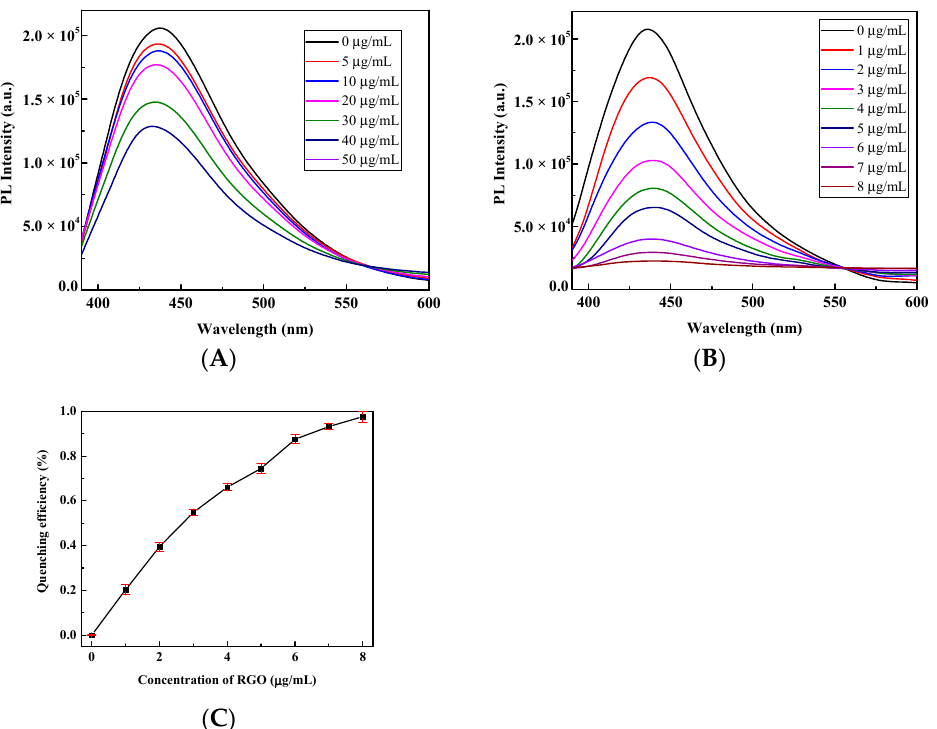
Figure 5. PL quenching of Anti-Lv-mAb/CQDs at different concentrations of ( A ) RGO and ( B ) RGO_PDDA, and ( C ) quenching efficiencies vary with the concentrations of RGO_PDDA.